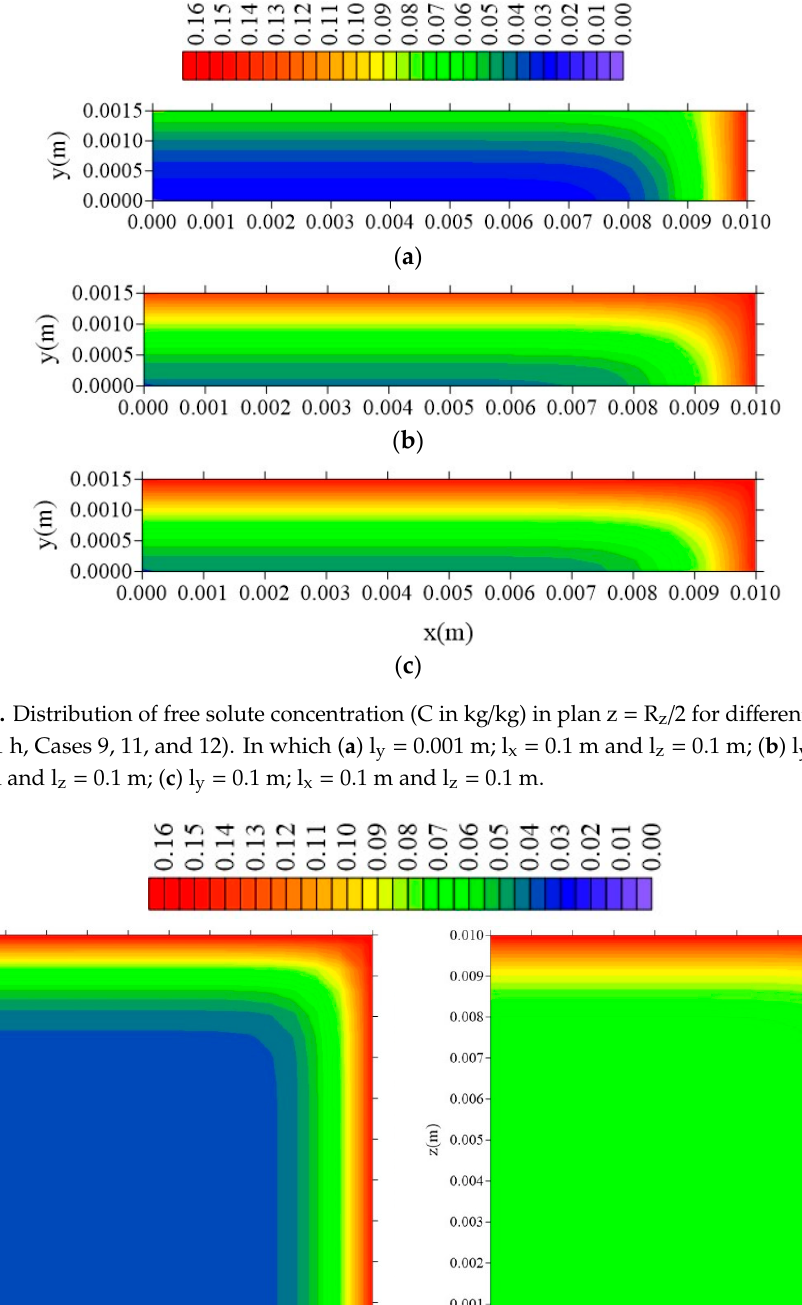
Figure 24. Distribution of free solute concentration (C in kg/kg) in plan x = R x /2 for different distances l y (t = 211 h, Cases 9, 11, and 12). In which ( a ) l y = 0.001 m; l x = 0.1 m and l z = 0.1 m ; ( b ) l y = 0.01 m;